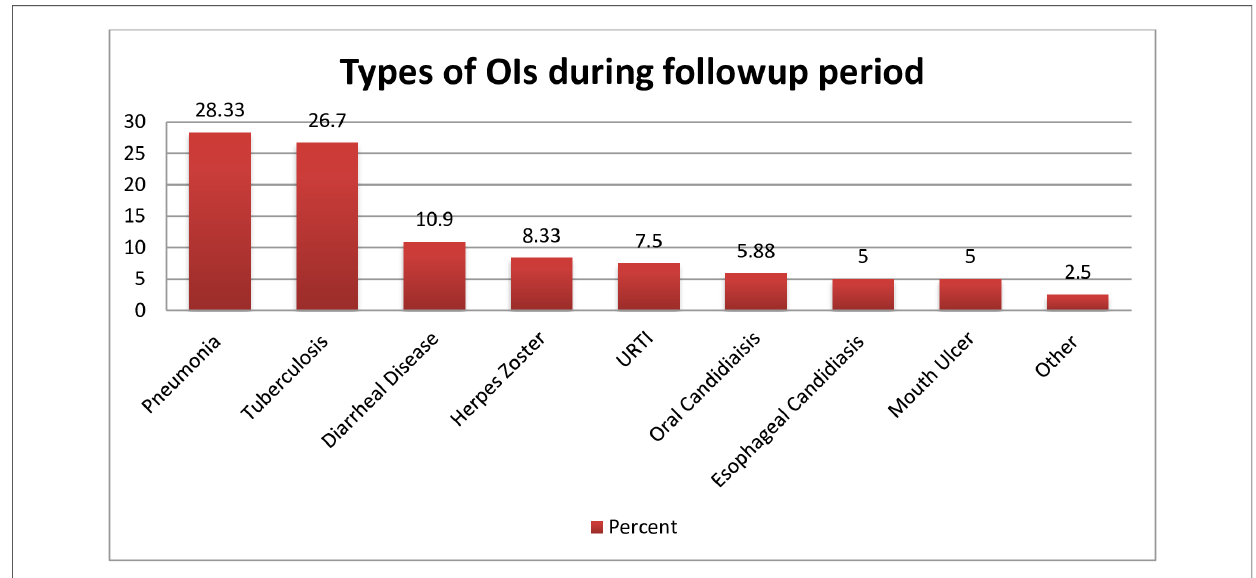
FIGURE 3 Common types of opportunistic infection observed among HIV-infected children receiving ART during the follow-up period at Amhara regional state comprehensive specialized hospitals, Ethiopia, 2022. Other=cryptococcal meningitis, Pneumocystis carinii pneumonia